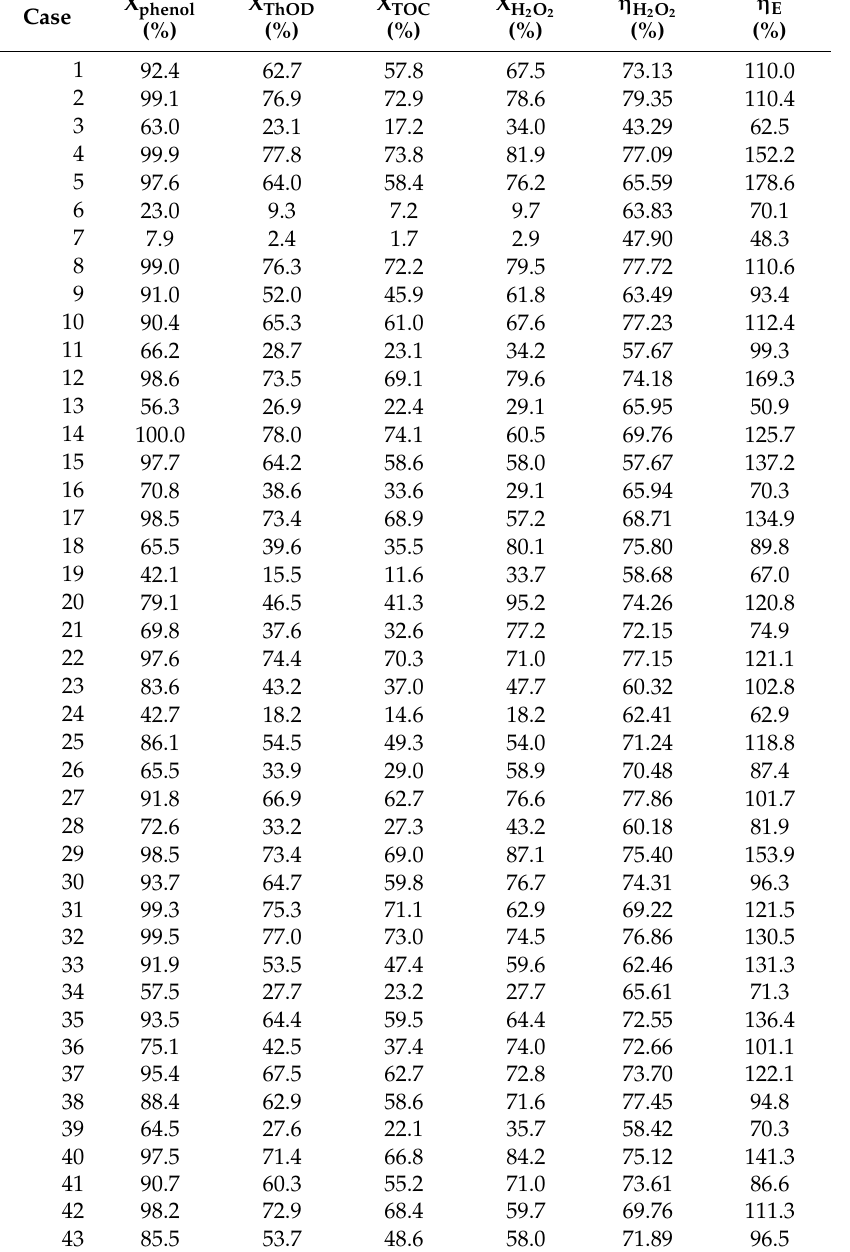
Table 2. Response variables obtained with the six-factor Doehlert